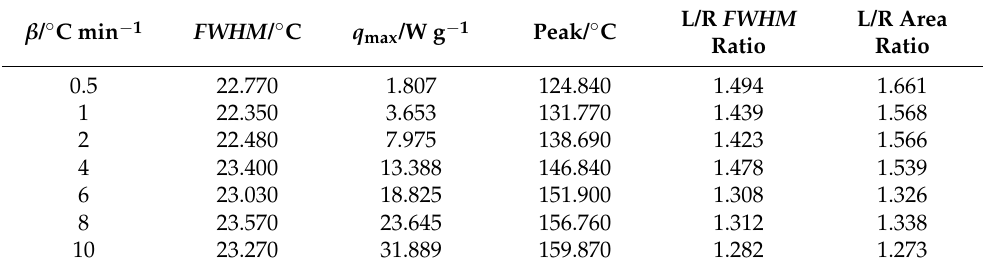
Table 3. Relevant parameters of Gaussian curve simulation tests on BTBPC data.